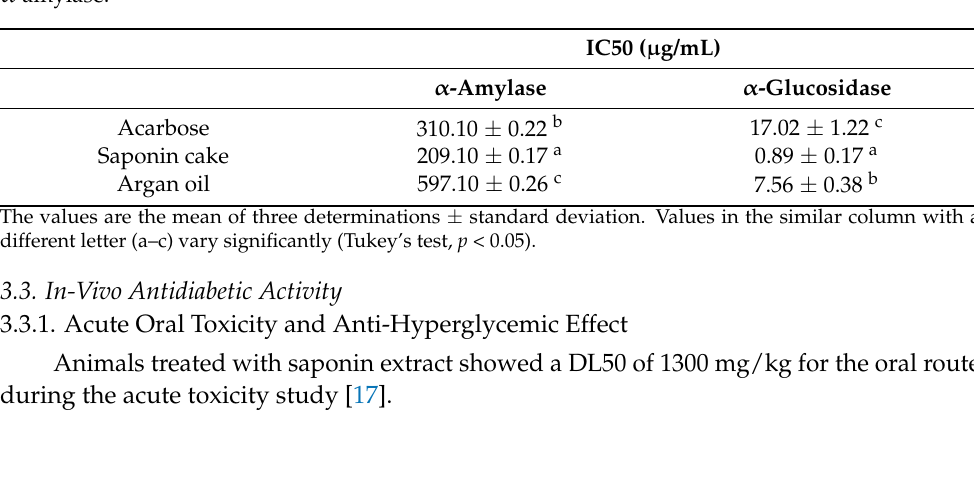
Figure 3. Average percentage of α-glucosidase and α-amylase inhibition versus concentration of Argan oil ( A ) and saponin Argan cake ( B ). Table 3. IC50 values of saponin Argan cake extracts and Argan oil on α -glucosidase inhibition and α